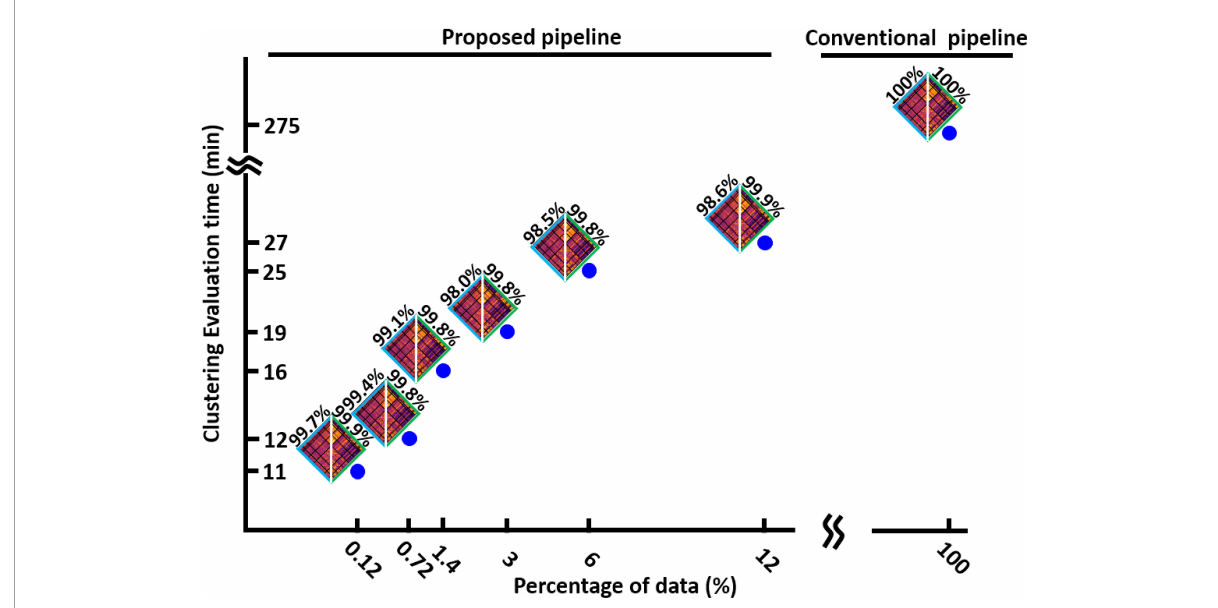
FIGURE5 The clustering evaluation time with conventional and proposed method. Reducing the percentage of the data used in each iteration of the first step, reduces the evaluation time. The proposed method is 25 times faster the conventional method. The estimated states and their similarity with states estimated from whole data are shown for each percentage of data.